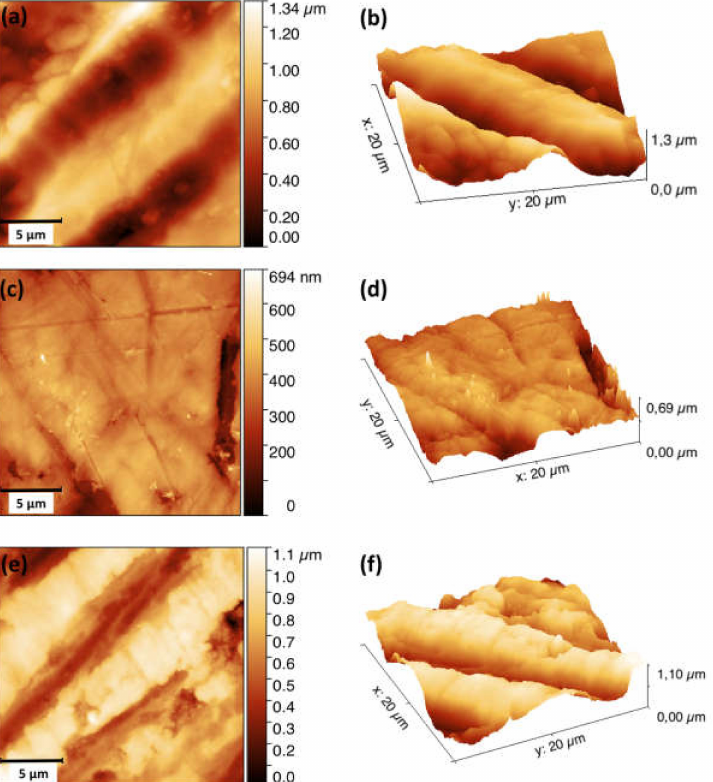
Figure 4. Representative 2D and 3D AFM topographies of ( a , b ) NiTi_Vis Plus, ( c , d ) NiTi_Azdent, ( e , f ) β